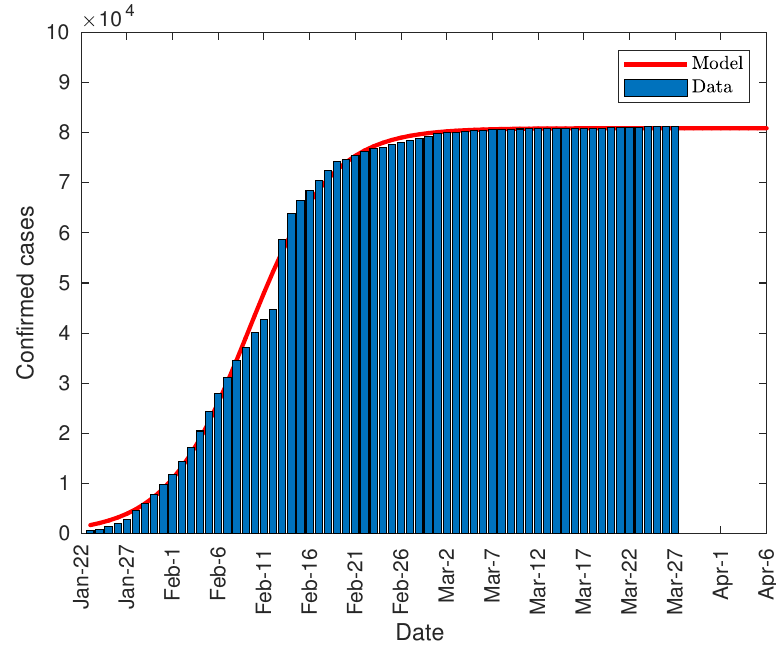
Figure 2. Total number of infected people in China.